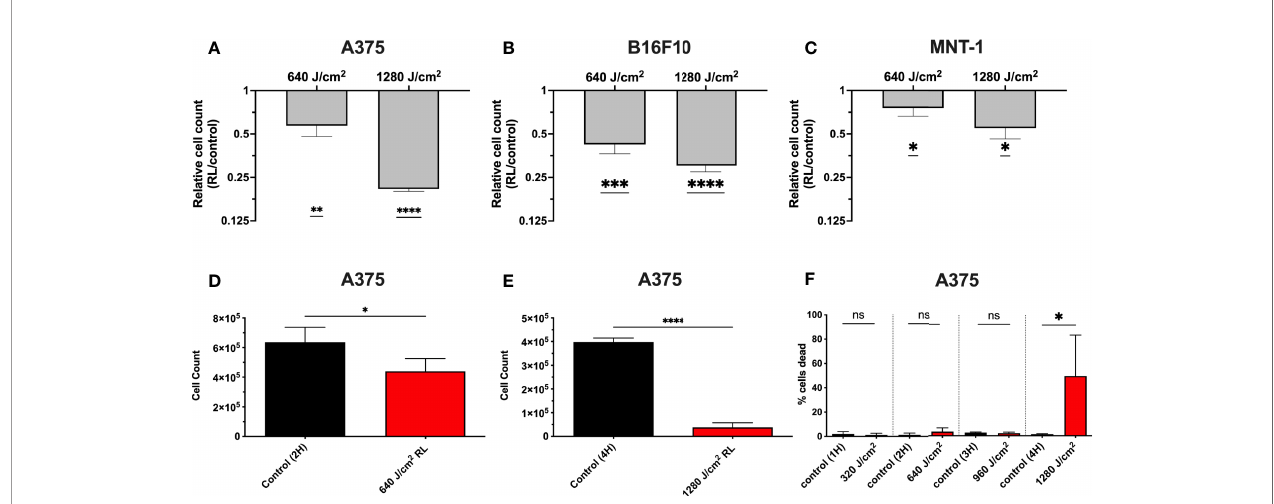
FIGURE 1 | RL causes a dose-dependent decrease in melanoma cell counts. (A) 48 hours after RL irradiation, relative cell counts were assessed in A375 (n=4), (B) B16F10 (n=5), and (C) MNT-1 (n=4) cells using crystal violet. The crystal violet was eluted and quanti fi ed using a Biotek plate reader, with an OD reading of 590- nm. The RL group ’ s 590-nm OD was indexed to matched-control for graphing of relative cell count. (D) Cell count was measured using a hemocytometer in A375 48 hours after treatment with 640 (n=4) and (E) 1280 J/cm 2 (n=4). (F) Cell viability was measured using a hemocytometer 48 hours after treatment with 640 (n=4) and 1280 J/cm 2 (n=4). A two-tailed T-Test (p<0.05) compared OD, cell count, and cell viability of RL treated cells to time-matched control. OD, optical density; RL, red light; 2H, 2 hours; 4H, 4 hours.*denotes p<0.05, ** denotes p<0.01, *** denotes p<0.01, **** denotes p<0.0001, and ns denotes not signi fi